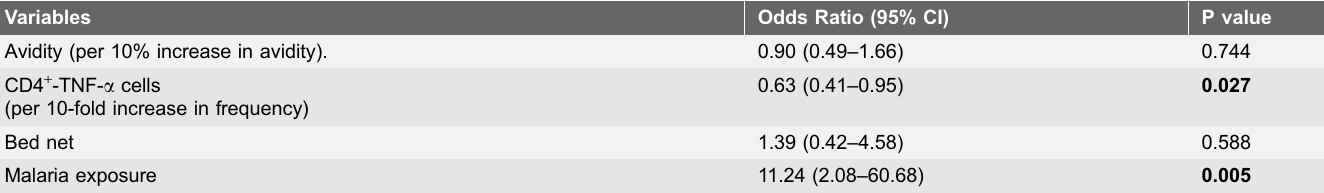
Table 2. Multivariable logistic regression analysis for the effect avidity on clinical malaria.